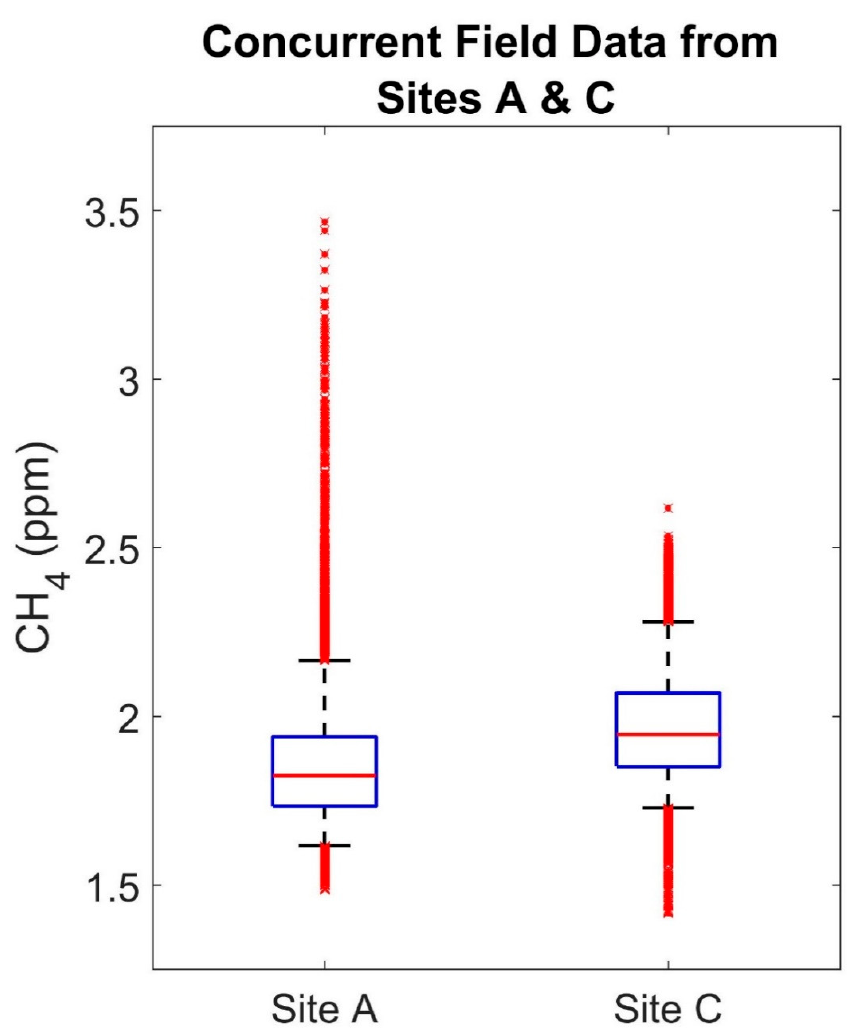
Figure 2. Concurrent field data from Sites A and C.